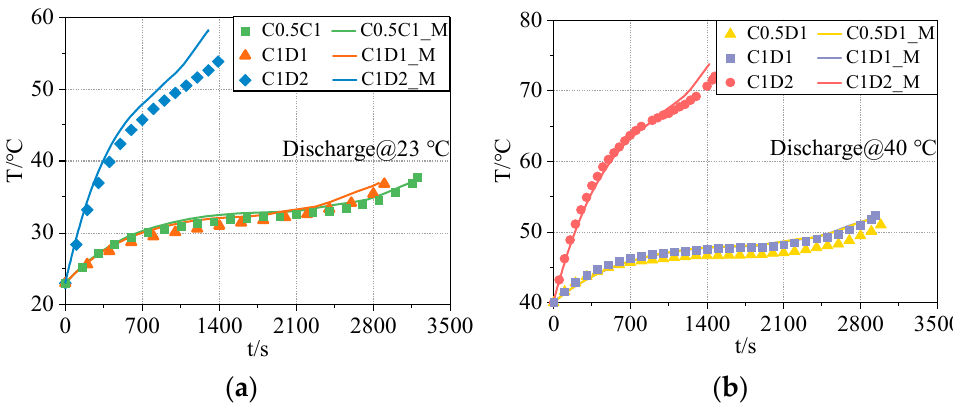
Figure 7. Validation of surface temperature rise of aging cells during discharge at ( a ) 23 °C and ( b ) 40 °C.